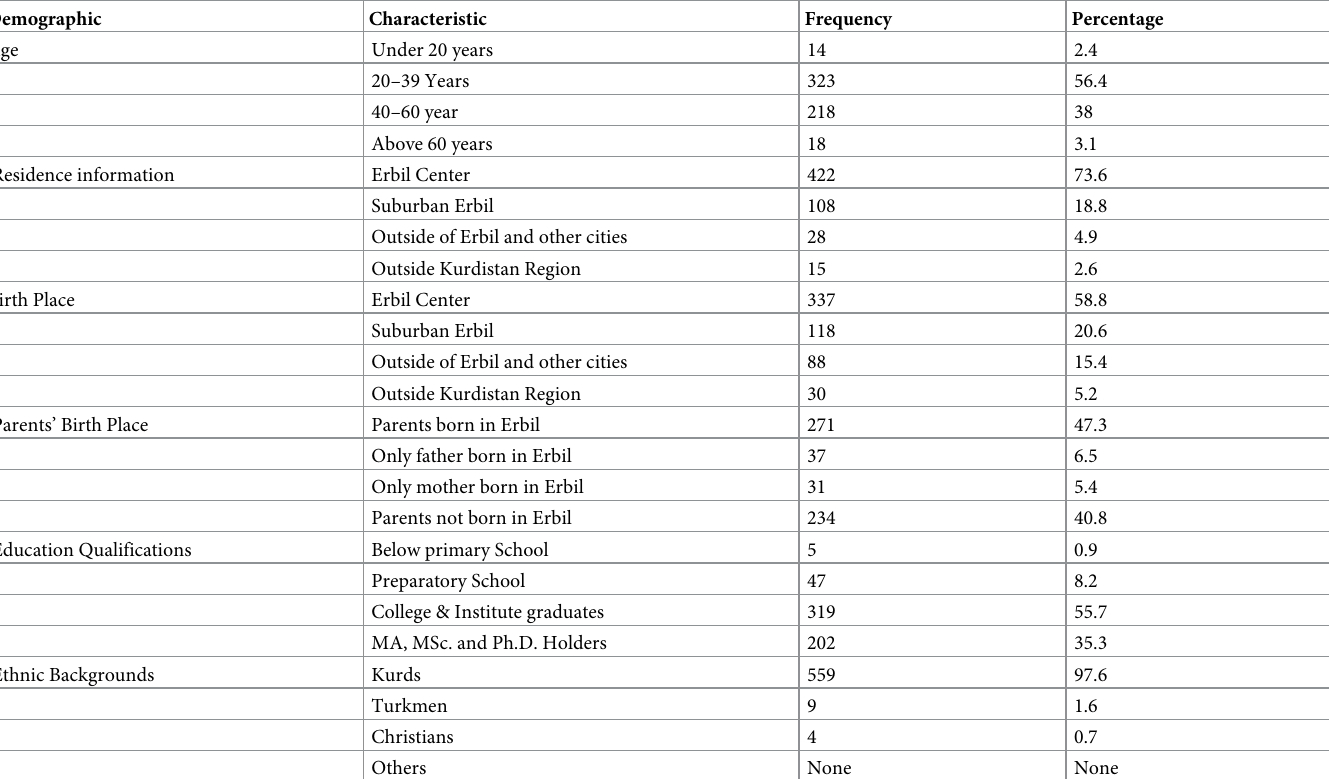
Table 1. The demographic profile of the study’s